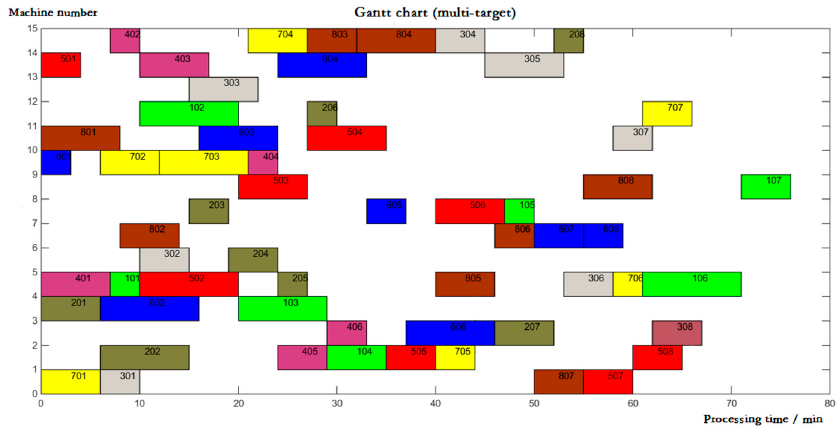
Figure 7. Multi-objective optimization results Gantt chart.